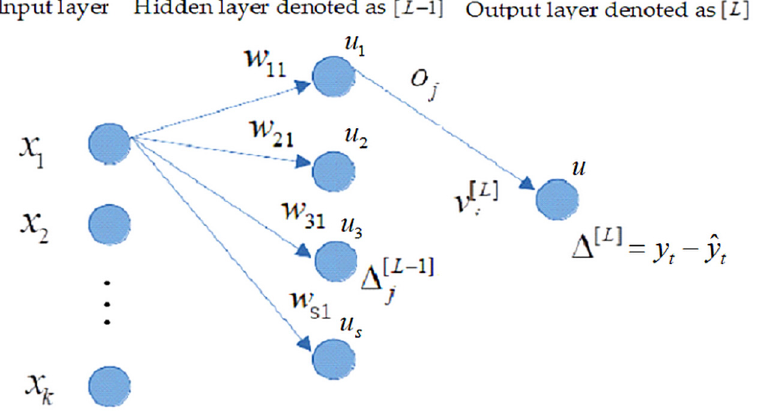
Figure 3. Weights updating in neural network layers (see Equations (6)–(9)).